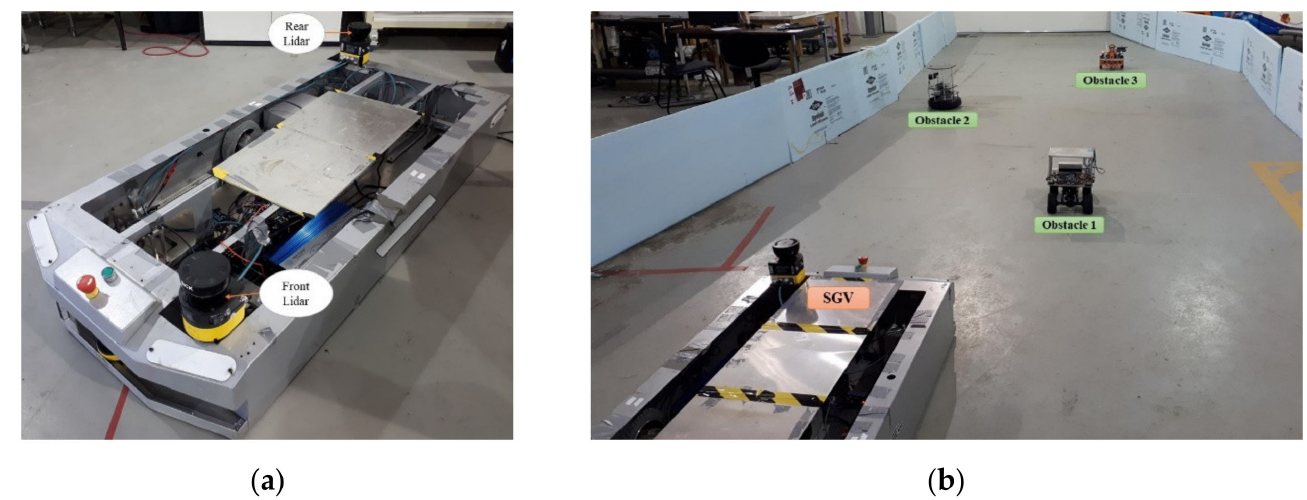
Figure 5. ( a ) The Self-Guided Vehicle (SGV); ( b ) the experimental